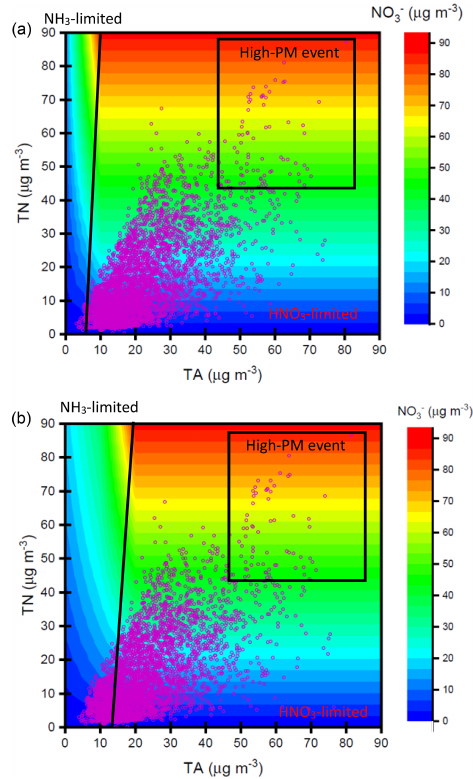
Figure 9. Nitrate concentrations simulated by ISORROPIA II model depending on TN and TA concentrations under (a) SO 2 − = 60µgm − 3 . The purple dots denote the 10µgm − 3 and (b) SO 2 − 4 observed TN and TA concentrations at the receptor site during the sampling